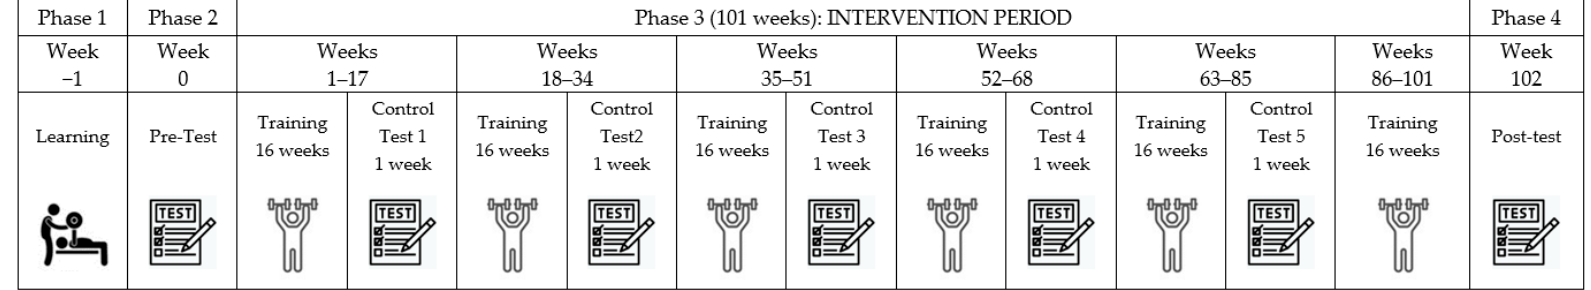
* Rest time between sets. ¥ 90° Seated Chest Press and 45° Leg Press.